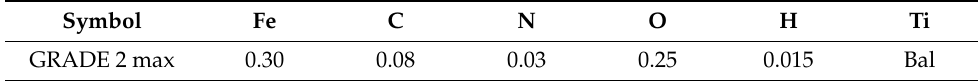
Table 1. The percentage chemical composition of GRADE 2 titanium alloy [36].